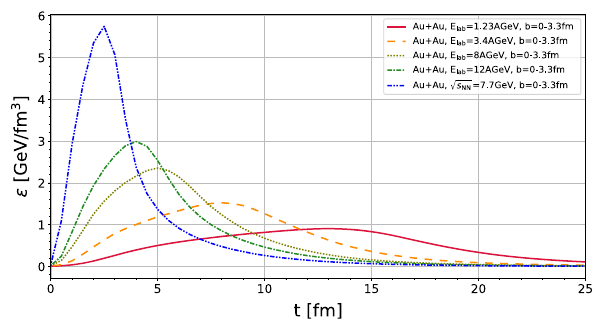
Fig. 1 Time evolution of the energy density in the center of the system for Au+Au collisions, 0–5% centrality class, at E lab = 1.23, 3.4, 8, √ s NN = 7.7 GeV 12 AGeV and